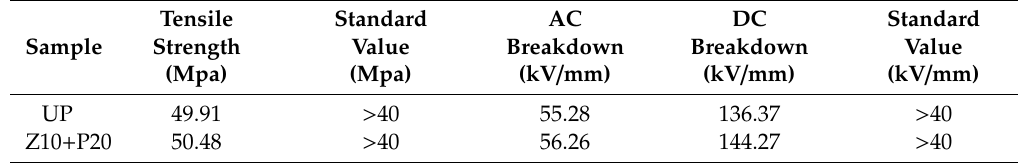
Table 2. Tensile strength and electric breakdown test